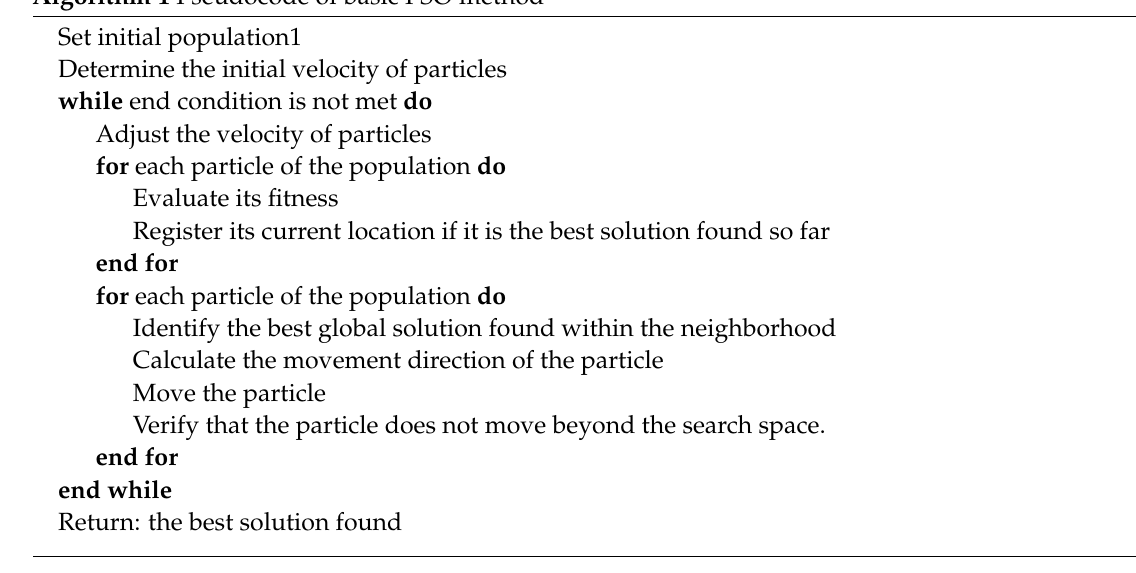
Algorithm 1 Pseudocode of basic PSO